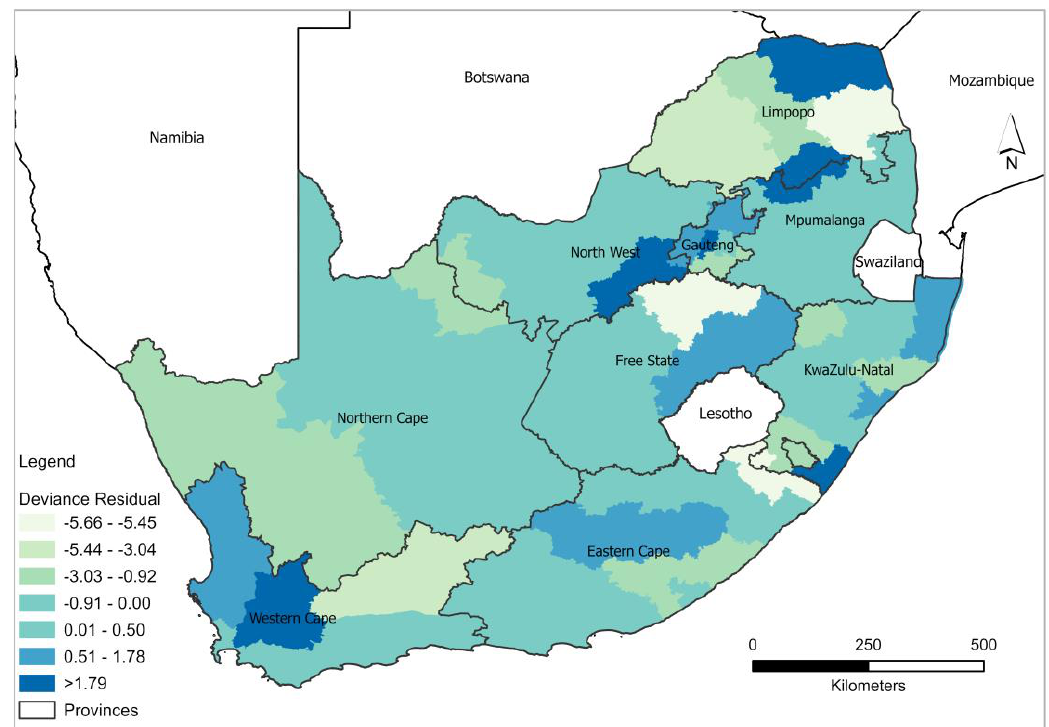
Figure 3. Spatial distribution of GWPR model deviance residuals.